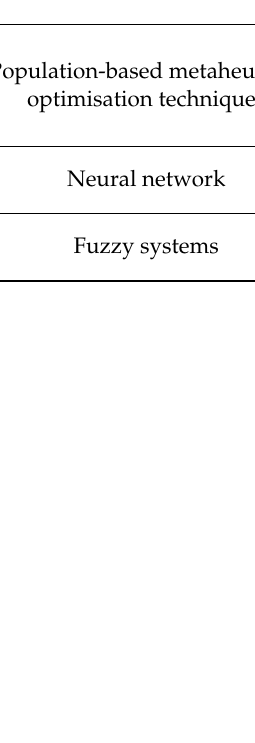
Selected Algorithms simulated algorithms, hill